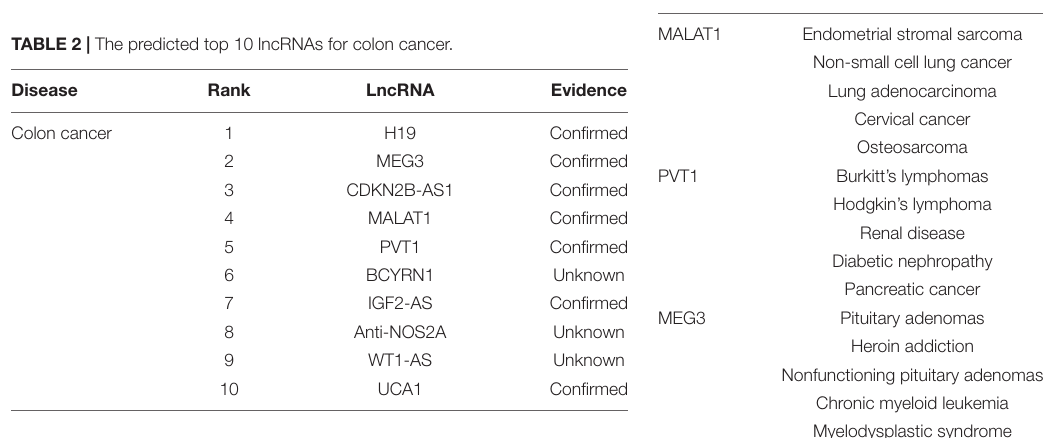
TABLE 3 | The predicted top 10 lncRNAs for hepatocellular carcinoma.